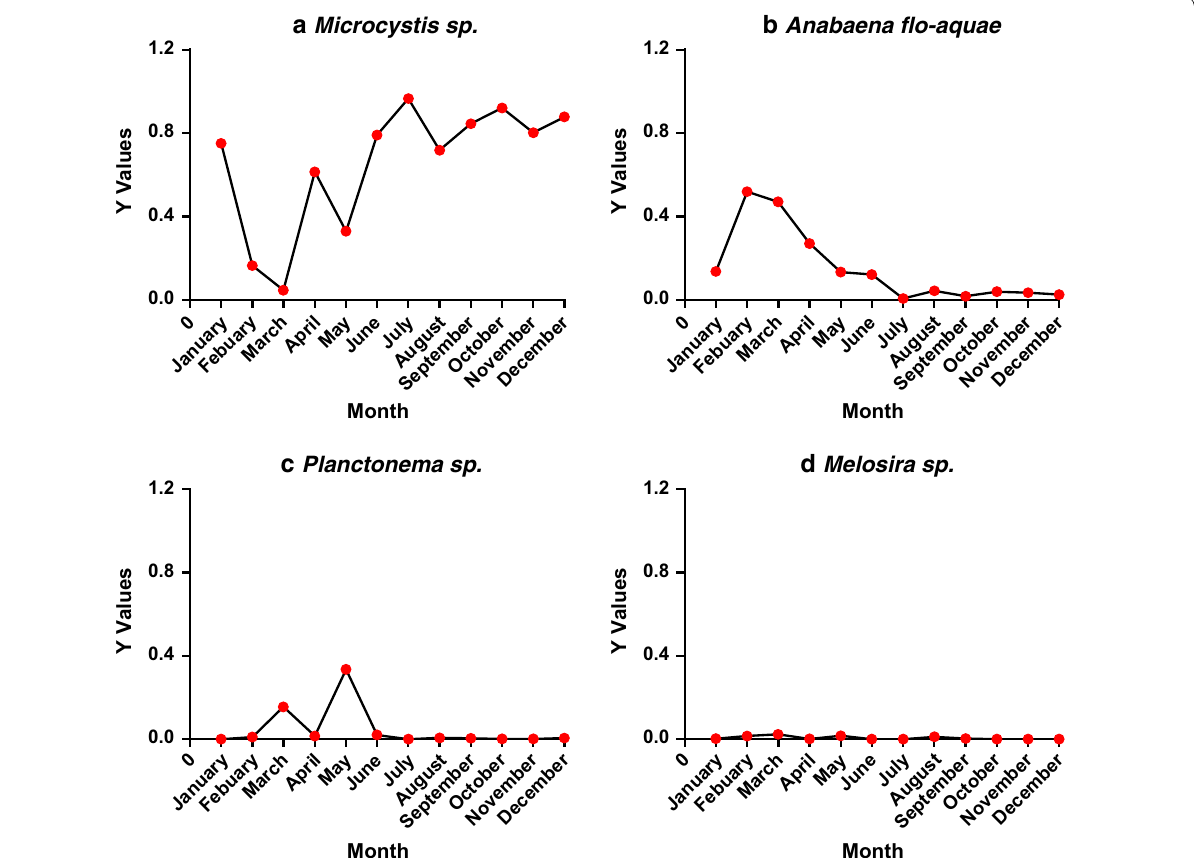
Fig. 2 Percentages of dominant taxa ( Microcystis sp., Anabaena flos-aquae , Planctonema sp. and Melosira sp.) in phytoplankton community and their temporal changes from January to December of 2015 in Tai